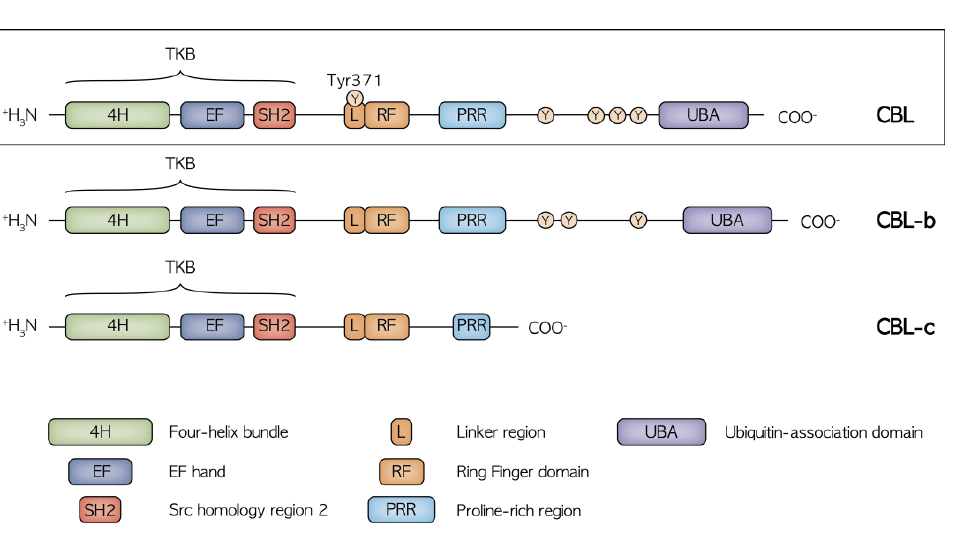
Figure 1. Structure of the CBL, CBL-b and CBL-c proteins with the relative functional domains and main phosphorylation sites. CBL and CBL-b are structurally related while CBL-c lacks the C terminal domain, including the UBA region and the proline and tyrosine rich region, mediating the binding to the SH2 and SH3 domain-containing proteins. The highly conserved N terminal region with the TKB, Linker and RF domains is crucial in the regulation of receptor and non-receptor tyrosine kinase activity.